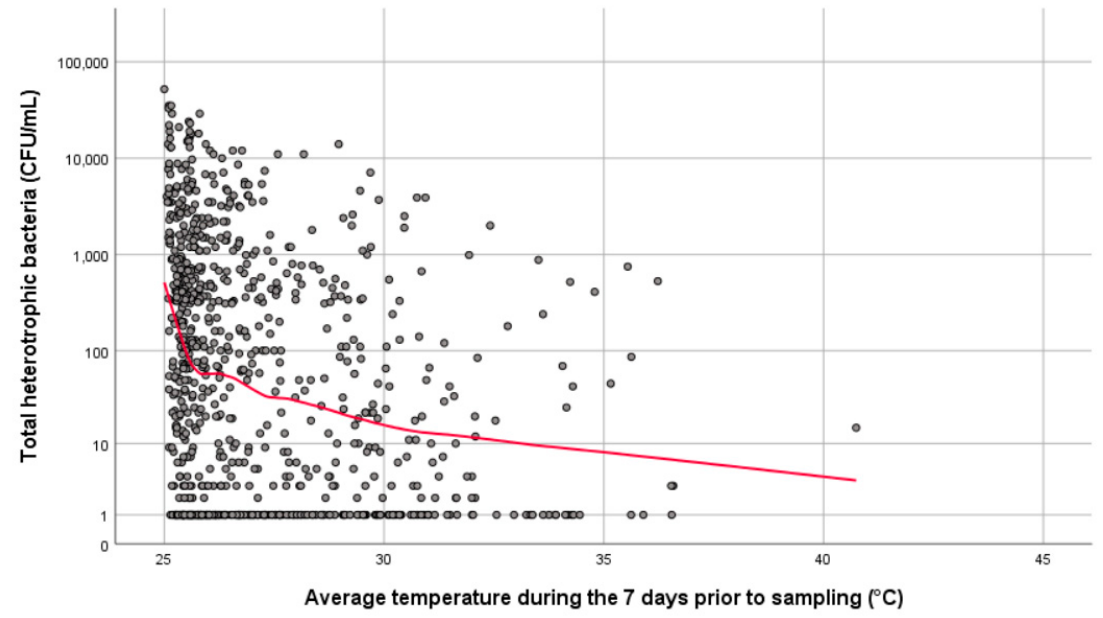
Figure 3. Simple scatter plot with loess line of fit showing the association between total heterotrophic bacteria (CFU/mL) and average water temperature (°C) during the 7 days prior to sampling.